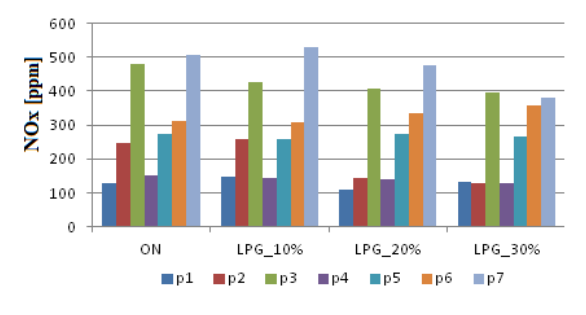
Fig. 11. The comparison of NO x emissions